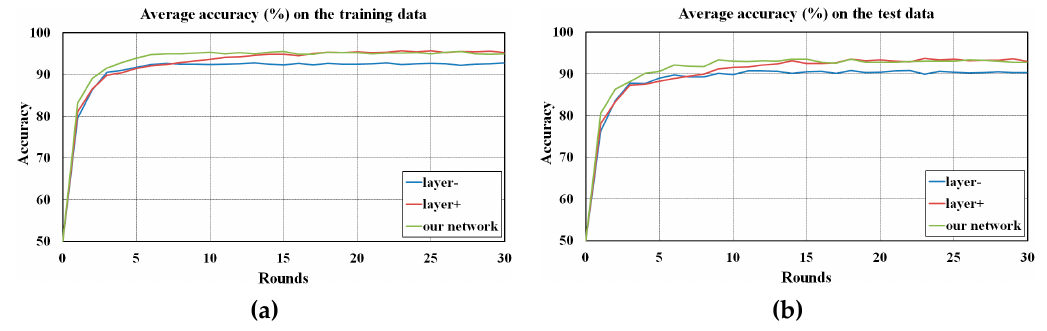
Figure 9. Comparison of average accuracies for each round between training ( a ) and test ( b ) data with layer − , layer+, and our network.